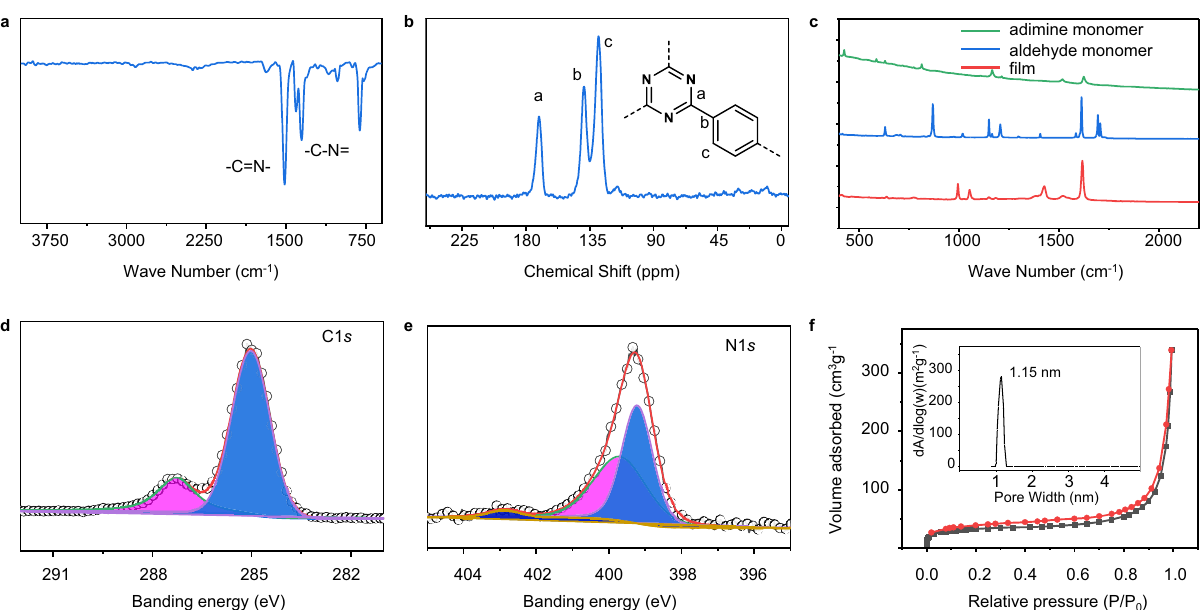
Fig. 4 The structure characterization of the CTF fi lm. a FT-IR spectra of the CTF fi lms. b 13 C-NMR spectra of the CTF fi lms. c Raman spectra of monomers and CTF fi lms. d , e X-ray photoelectron spectrum of the CTF fi lms. f N 2 adsorption and desorption isotherms (77 K); insert: the pore size distributions.